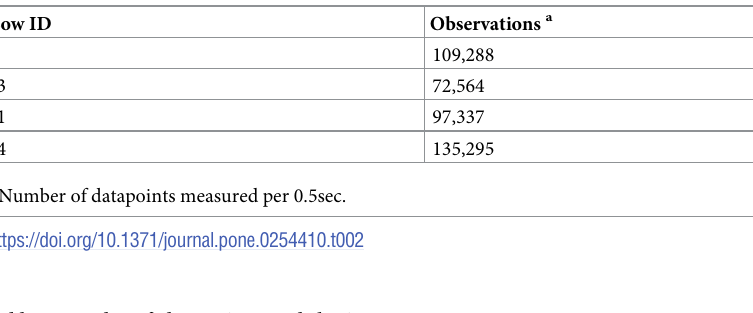
Table 3. Number of observations per behavior.